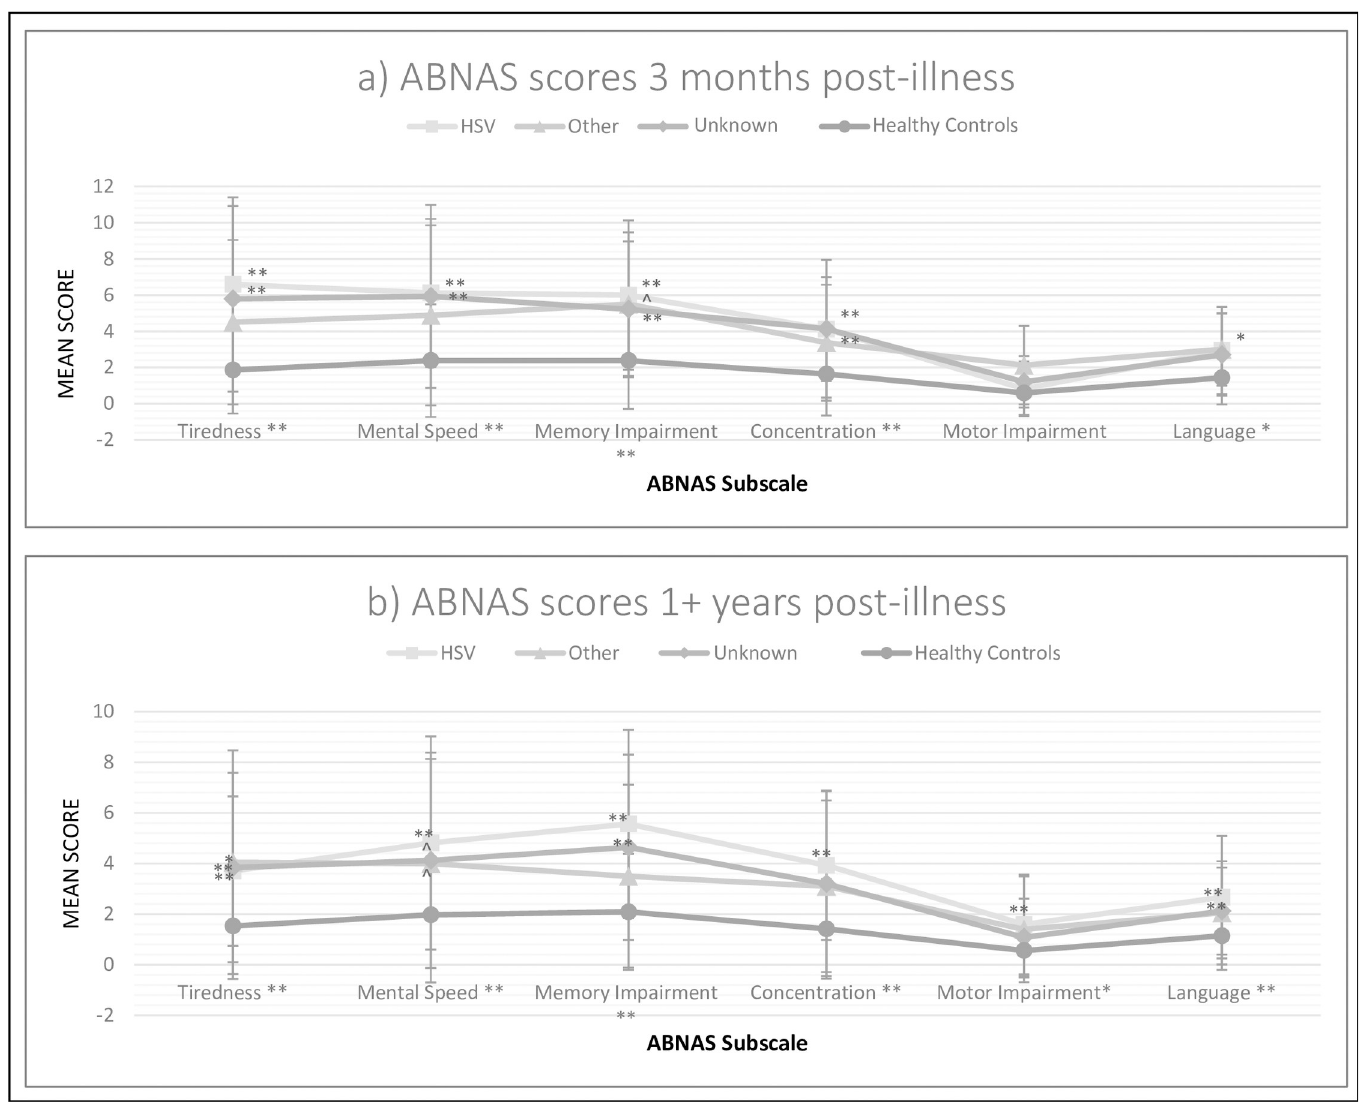
Fig 3. Subjective cognitive complaints for each group (ABNAS subscale scores). The error bars represent the standard deviation of the mean score within each group. (a) At the short-term assessment, a mean of 4 months post-discharge (in the short- and medium-term outcome cohort) and (b) at the long-term assessment, at least 1-year post-discharge (in the long-term outcome cohort). Notations: For main analyses of subscales (all Kruskal Wallis), significance is labelled adjacent to the subscale name along the x-axis, alpha p = 0.05, � p � 0.05, �� p � 0.01; For the breakdown of main analyses using Mann Whitney U post hoc, significance is labelled adjacent to data points within the figure, corrected alpha p = 0.02, � p � 0.02, �� p � 0.01, ^ trending significance (p = 0.03); Abbreviations: ABNAS (A-B Neuropsychological Assessment Schedule).